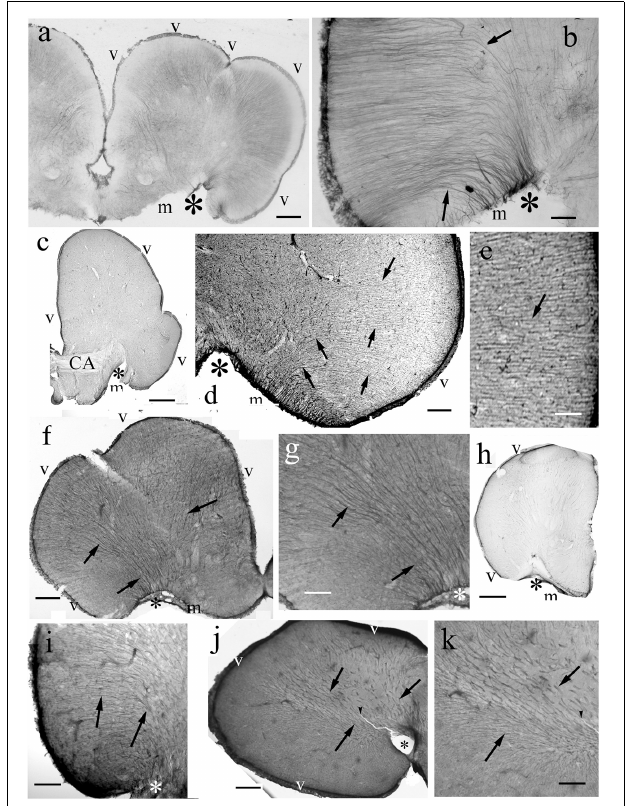
FIGURE 4 | Teleost telencephala: ‘fan-shaped’ convergence of the radial glial processes. Asterisk: the center of eversion, arrows: radial glia, note the intense curvature, m,v: meningeal and ventricular surfaces. (a) Eel telencephalon, the eversion is complete, asterisk marks its center. Scale bar: 120 µ m. (b) Detail of an eel telencephalon. The radial processes converge to the center of eversion (asterisk), the entorhinal fissure. Note the intense curve of processes (arrows) on the lateral part. Scale bar: 50 µ m. (c) Silhouette of a section of a knifefish telencephalic hemisphere, CA: ant. commissure. Scale bar: 700 µ m. (d) Detail of an knifefish telencephalon near the center of eversion. Scale bar: 120 µ m. (e) An enlarged detail of the lateral ventricular surface seen in panel (d) for a better demonstration of the glial processes. Scale bar: 40 µ m. (f) Goldfish telencephalon. Scale bar: 250 µ m. (g) Lateral part of goldfish telencephalon enlarged. Arrows and asterisks mark identical details here and in the previous panel. Scale bar: 120 µ m. (h) Silhouette of a section of a catfish telencephalic hemisphere. Scale bar: 500 µ m. (i) Detail of a catfish telencephalon. Asterisks mark identical details here and in the previous panel. Scale bar: 120 µ m. (j) Sander telencephalon. Scale bar: 200 µ m. (k) Midpart of sander telencephalon enlarged. Scale bar: 100 µ m.